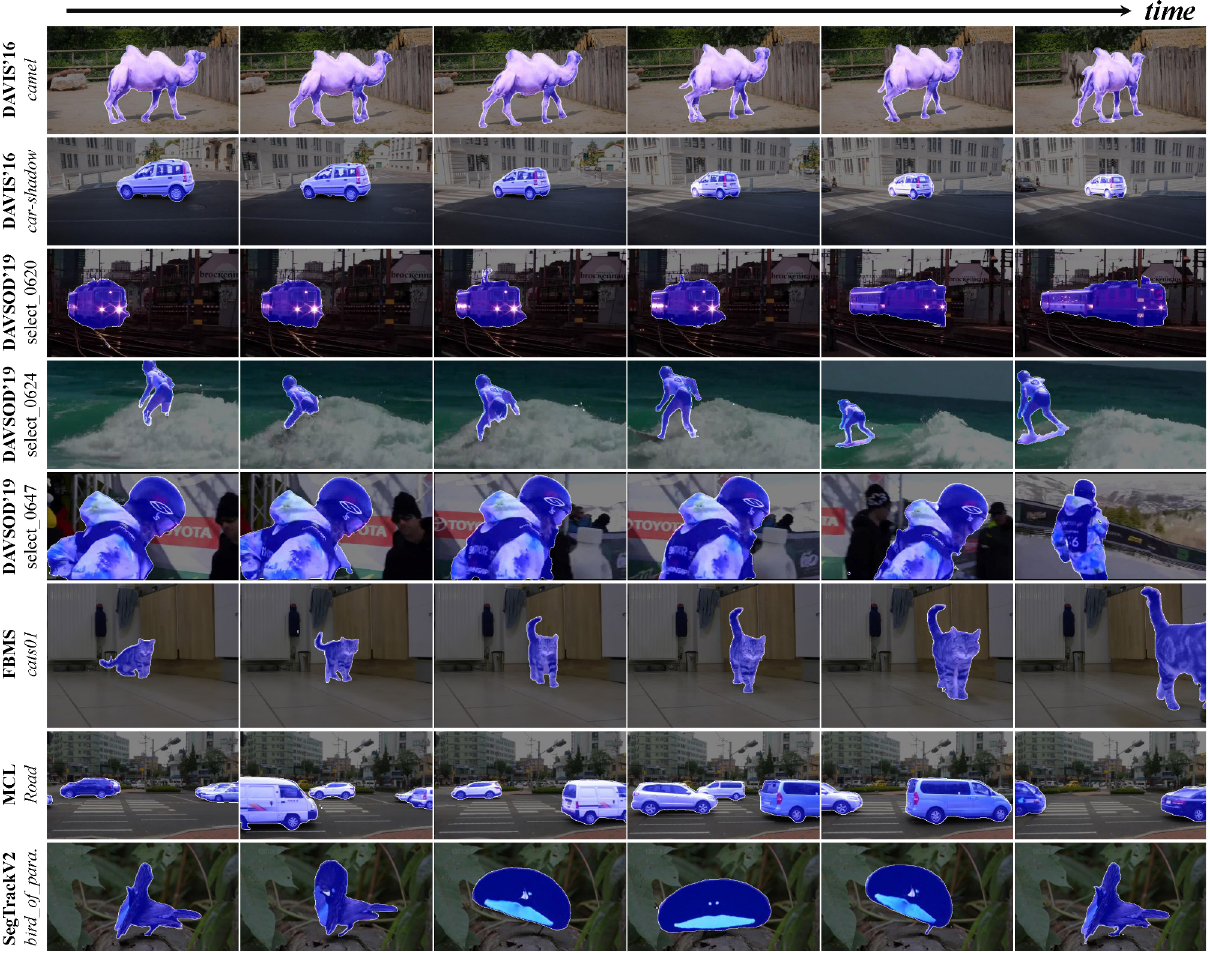
Fig. 7 Qualitative results on five datasets, including DAVIS 16 [35], MCL [85], FBMS [86], SegTrack-V2 [44], and DAVSOD 19